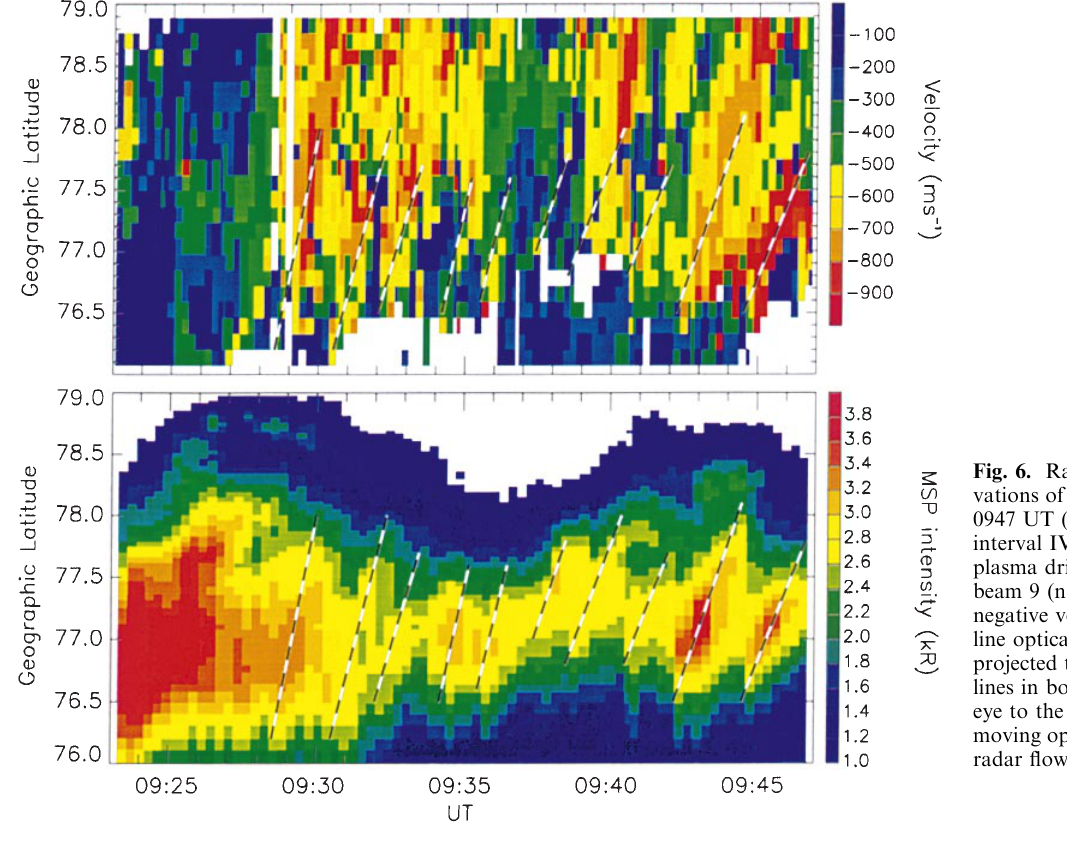
Fig. 6. Radar and MSP obser- vations of the period 0923 UT to 0947 UT (end of interval III and interval IV). (a) Line-of-sight plasma drift velocities along beam 9 (note: the scale involves negative velocities only). (b) Red line optical emission intensities projected to 250 km. The dashed lines in both panels are fits-by- eye to the optical poleward- moving optical transients and the radar